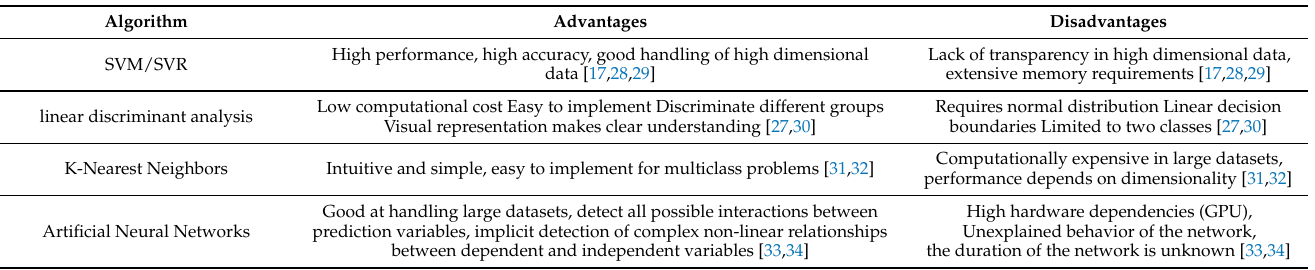
Table 1. Advantages and disadvantages of machine-learning algorithms